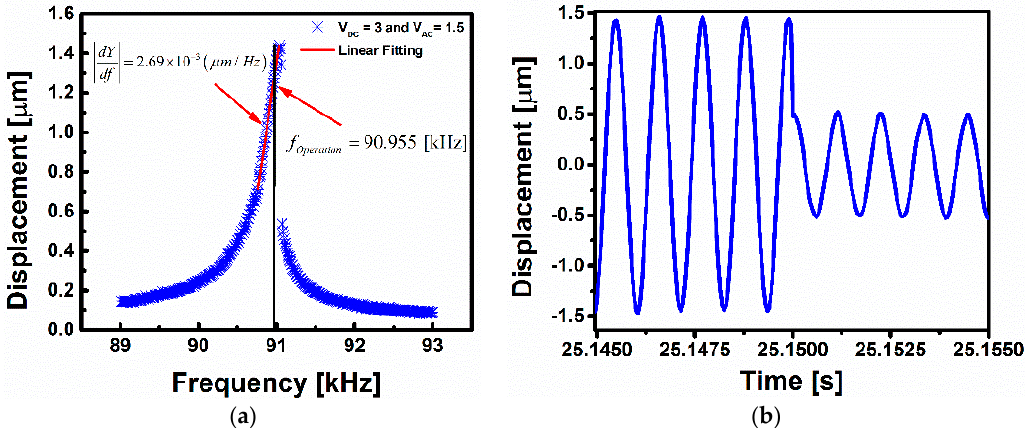
Figure 7. ( a ) Frequency response with the linear fitting of the upper branch at 220 mTorr. The linearly-fitted curve can be used to relate the amplitude change to the frequency shift, and hence, the amount of absorbed mass; ( b ) Time history of the beam displacement upon gas exposure indicating the sudden jump down, and hence, the switching event.